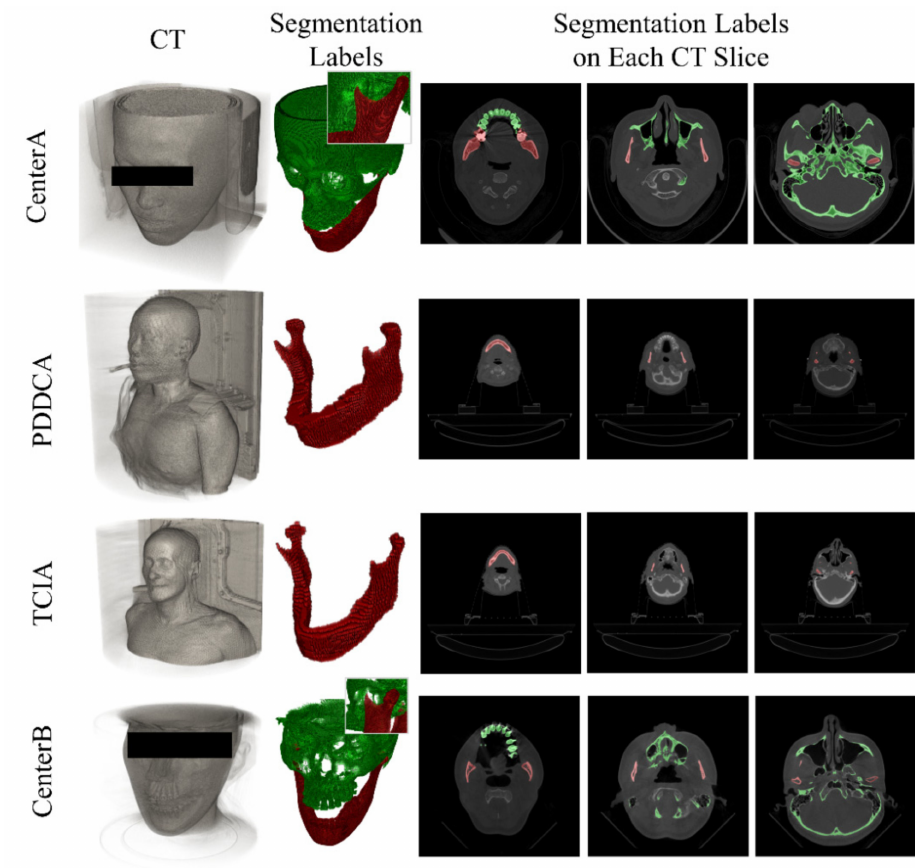
Figure 2. Example cases of the